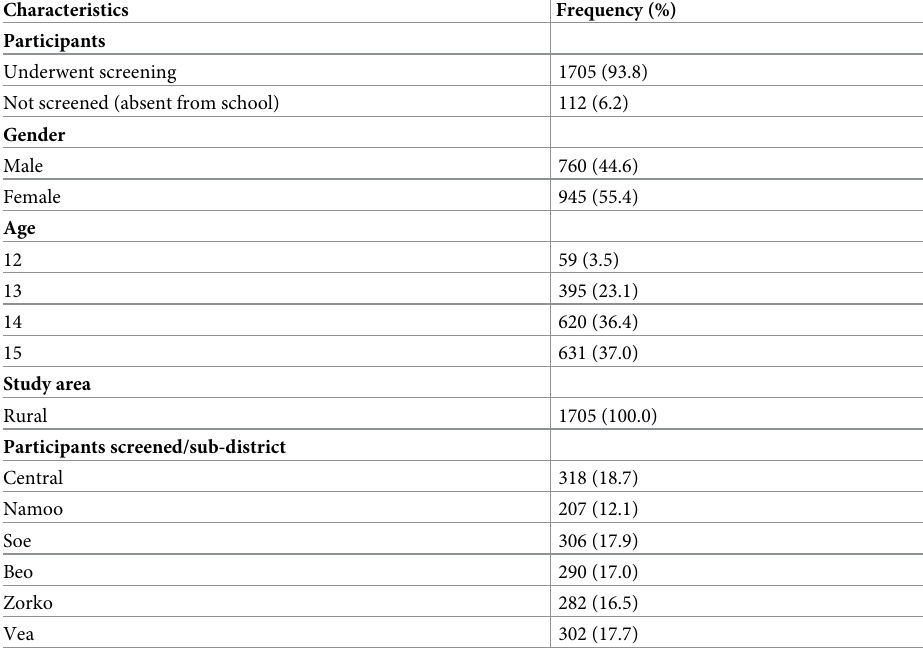
Table 1. Characteristics of participants